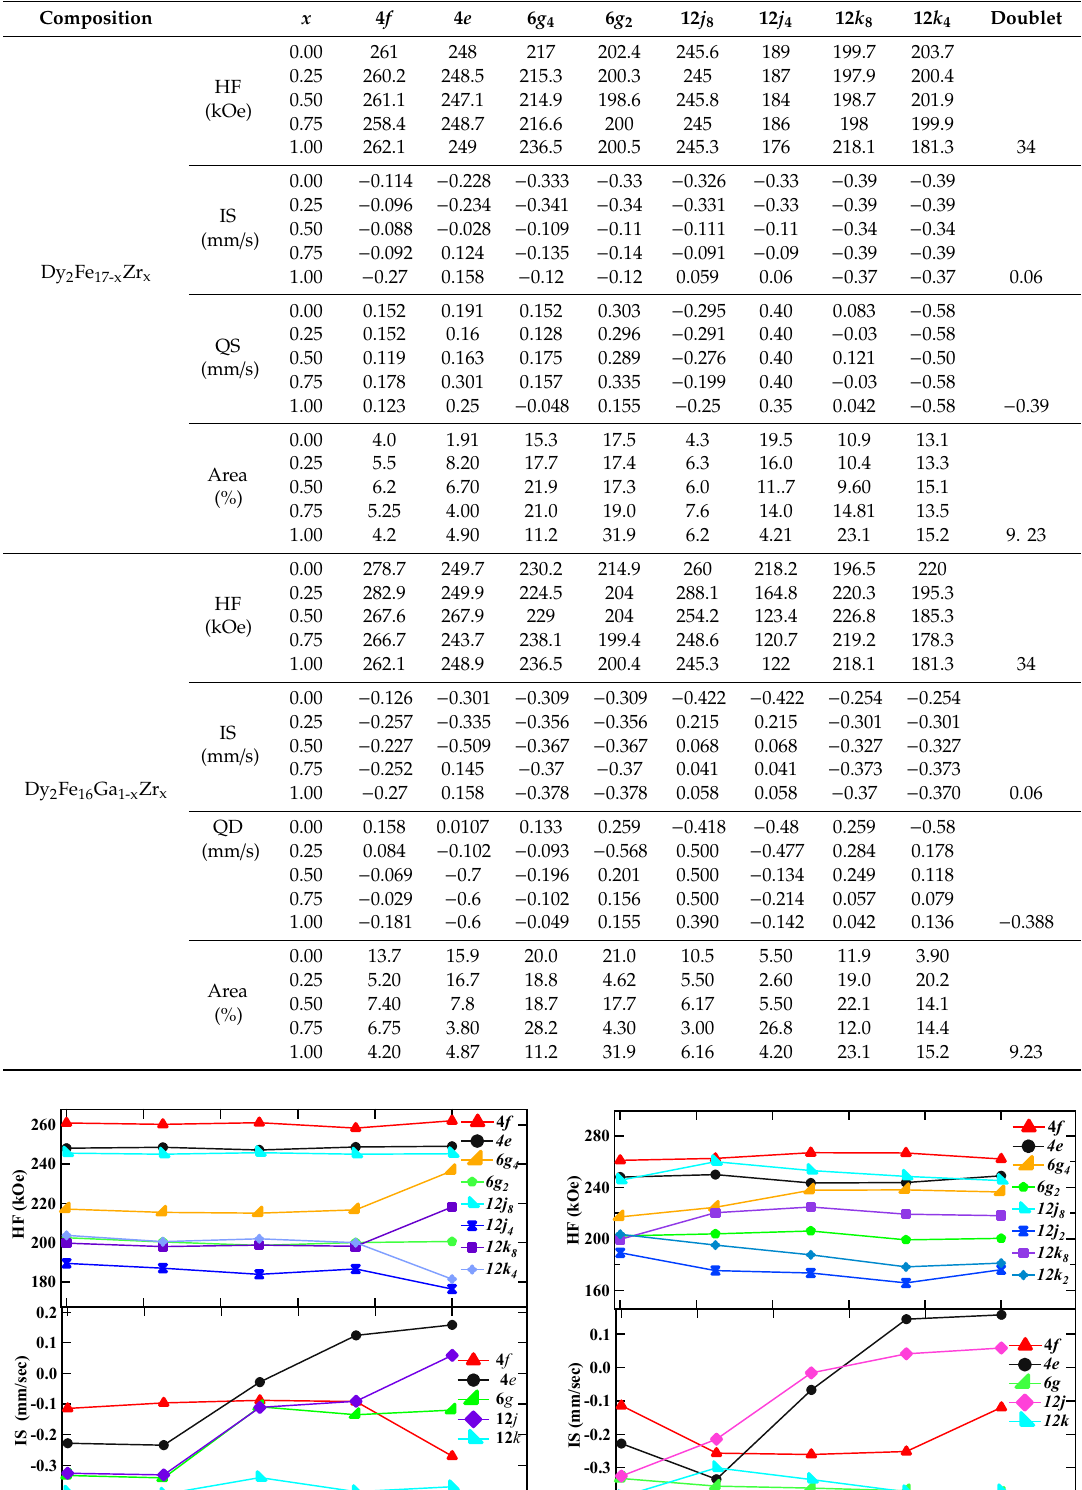
Table 4. The RT hyperfine parameters, HF (kOe), IS (mm / s), QS (mm / s), and area (%) of the Dy 2 Fe 17 − x Zr x and Dy 2 Fe 16 Ga 1 − x Zr x .